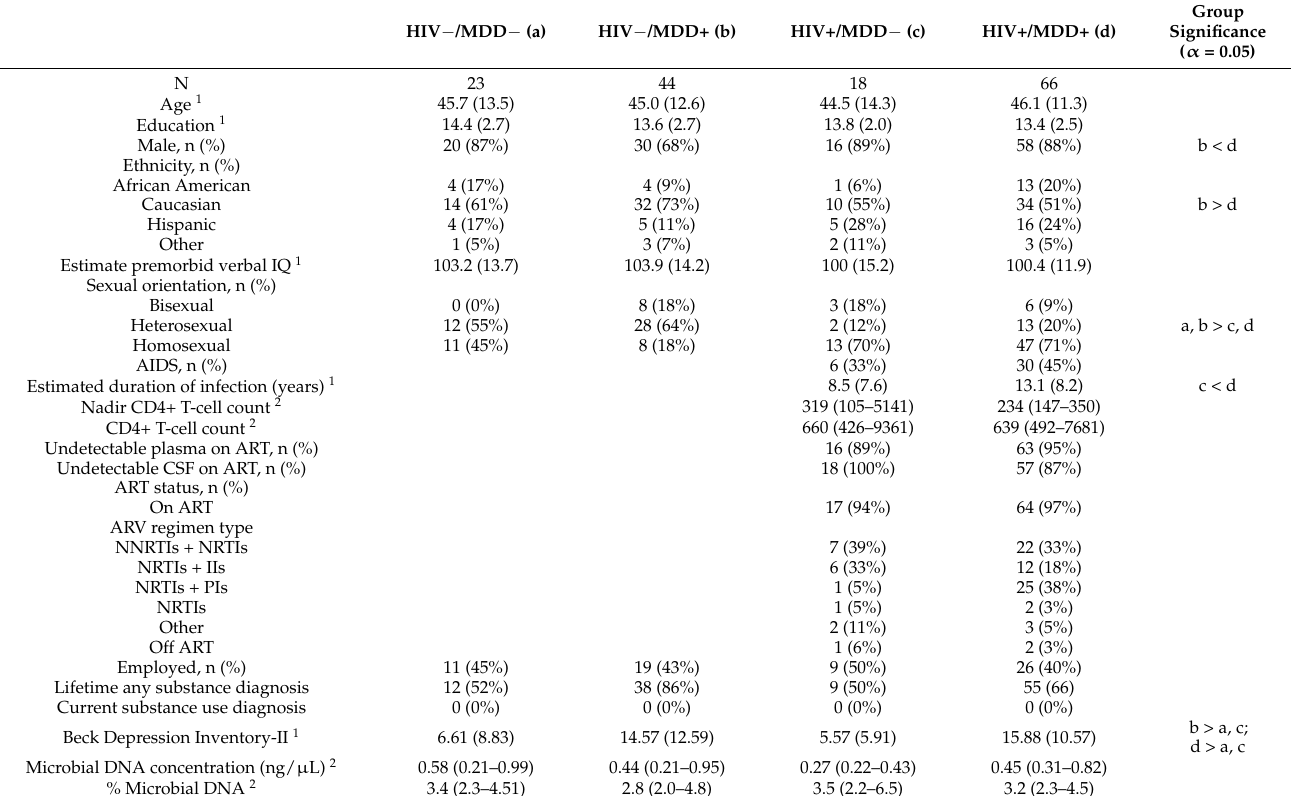
Table 1. Comparison of demographic and clinical characteristics between HIV/MDD